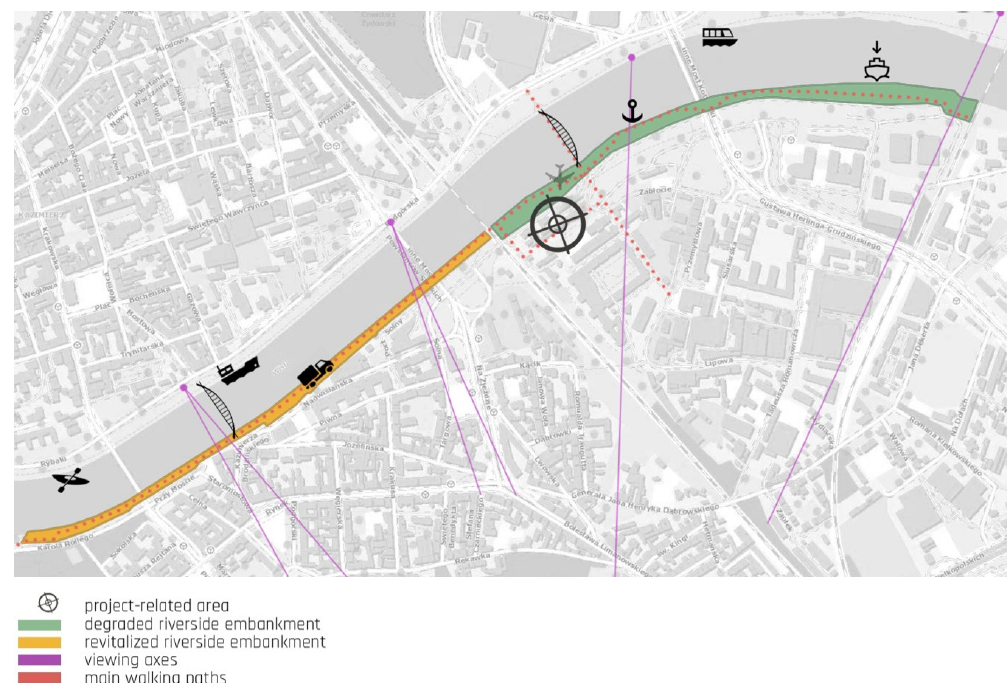
Figure 9. Main vistas in the context of Podolski Boulevard (Bulwar Podolski) (elaborated by E. Latusek).